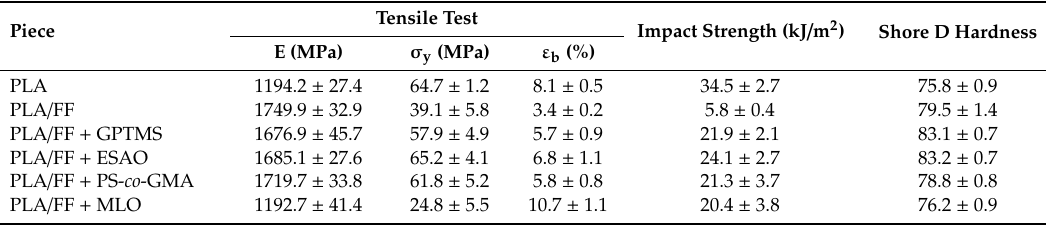
Table 2. Mechanical properties of the polylactide (PLA) / flaxseed fiber (FF) pieces compatibilized with (3-glycidyloxypropyl) trimethoxysilane (GPTMS), epoxy-based styrene-acrylic oligomer (ESAO), poly(styrene-co-glycidyl methacrylate) (PS- co -GMA), and maleinized linseed oil (MLO) in term of elastic modulus (E), tensile strength at yield ( σ y ), elongation at break ( ε b ), impact strength, and Shore D